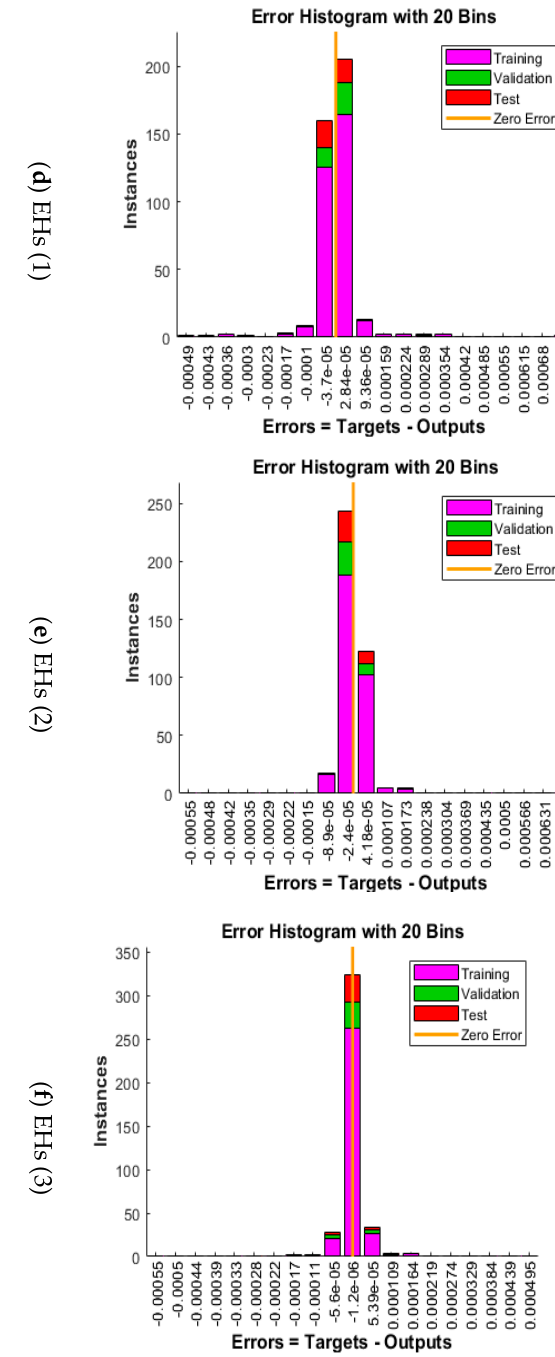
Figure 3. MSE and STs for the FO-MML love story model.